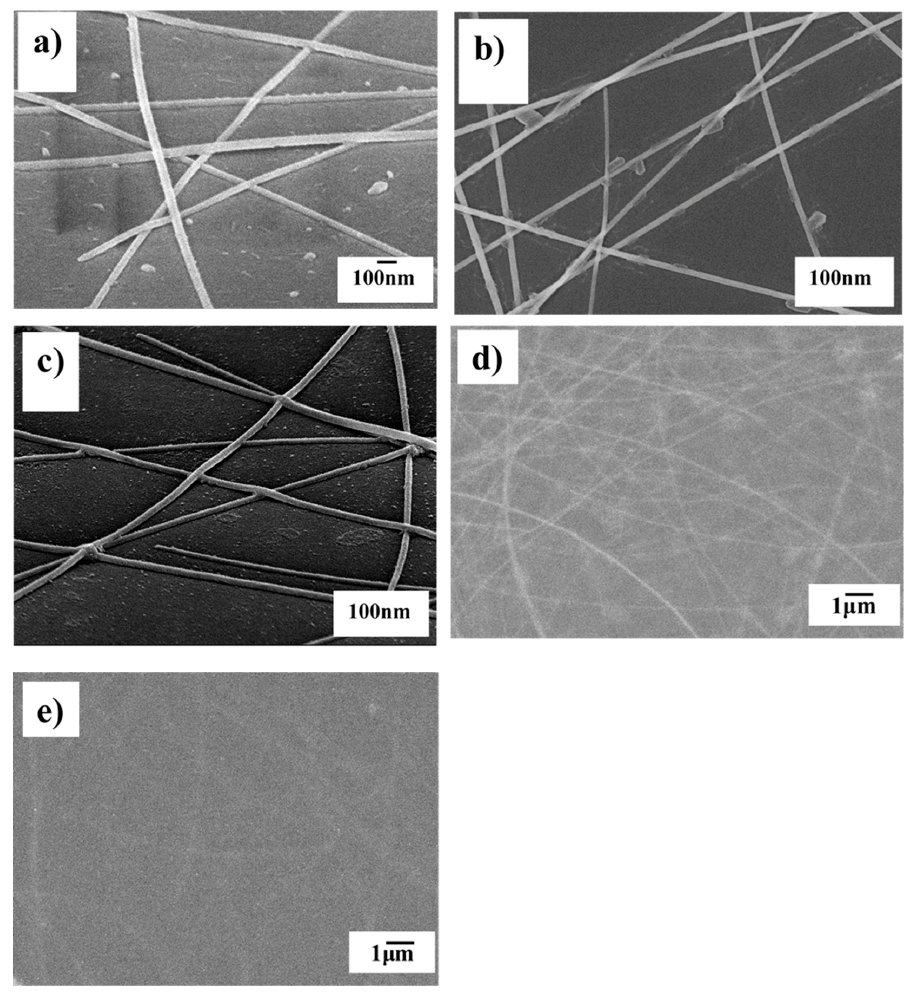
Figure 2. SEM images of: ( a ) glass/AgNWs; ( b ) glass/CT-AgNWs; ( c ) glass/HP-AgNWs; ( d ) glass/HP-AgNW/PEDOT:PSS/P3HT:PC 60 BM; and ( e ) glass/HP-AgNW/PEDOT:PSS/poly[(5,6-difluoro-2,1,3-benzothiadiazol-4,7-diyl)-alt-(3,3 ‴ -di(2-octyldodecyl)-2,2 ′ ;5 ′ ,2 ″ ;5 ″ ,2 ‴ -quaterthiophen-5,5 ‴ -diyl)] (PffBT4T-2OD): poly[4,8-bis(5-(2-ethylhexyl)thiophen-2-yl)benzo[1,2-b;4,5-b ′ ]dithiophene-2,6-diyl-alt-(4-(2-ethylhexyl)-3-fluorothieno[3,4-b]thiophene-)-2-carboxylate-2-6-diyl] (PTB7-Th):[6,6]-phenyl-C 71 -butyric acid methyl ester (PC 71 BM).